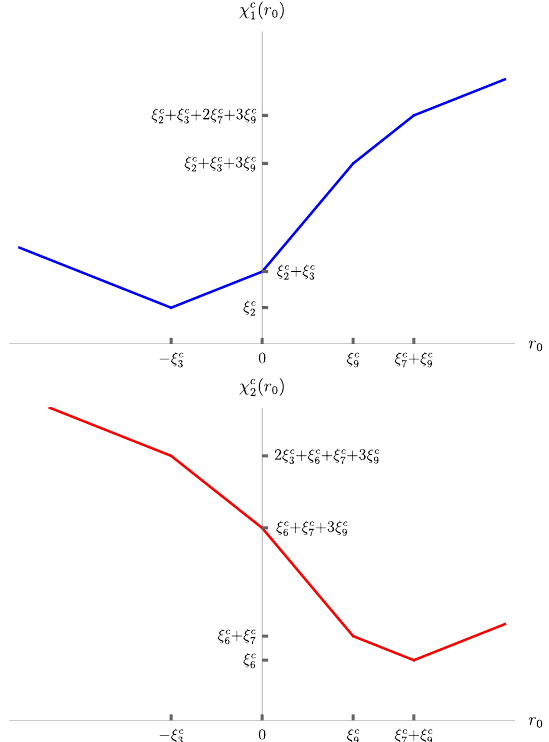
Figure 22: IIA profiles for the vertical reduction of resolution